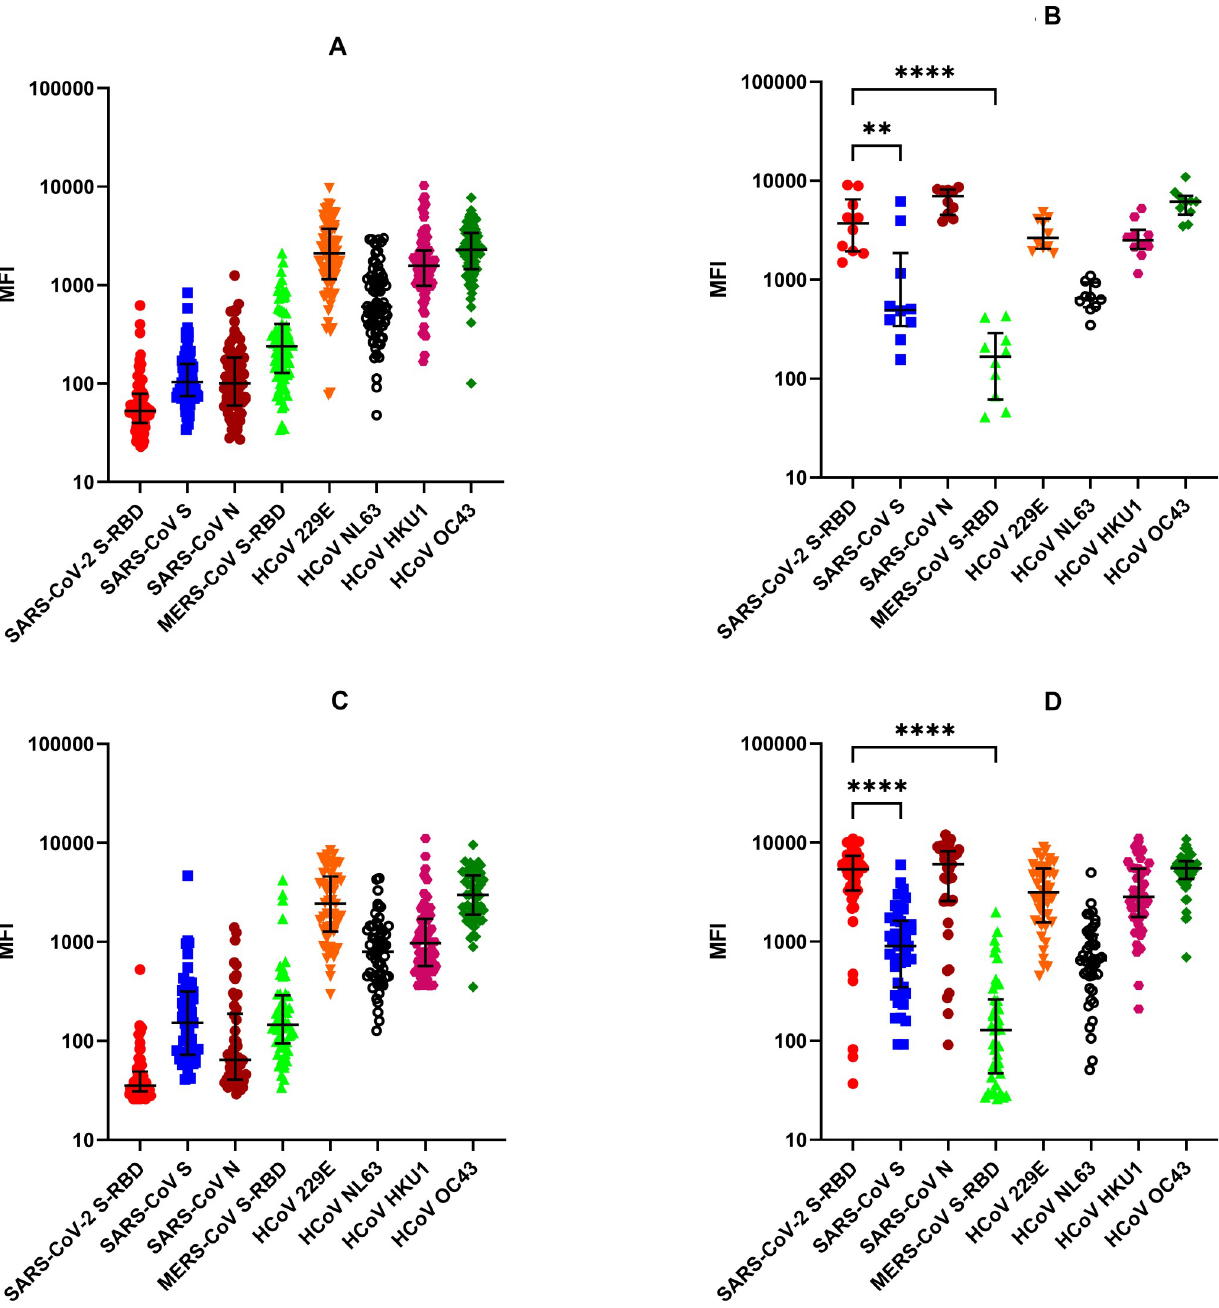
Fig 4. Total IgG levels detected by the multiplex antibody test against SARS-CoV-2 S-RBD, SARS-CoV S & N, MERS-CoV S-RBD and HCoVs. MFI values in log10 scale and IQR are shown, and the P values by one-way ANOVA and Tukey’s multiple comparison test between the groups are as follows: �� p < 0.001, ���� p < 0.0001. (A) Healthy Controls from USA, (B) COVID-19 Patients from USA, (C) Healthy Controls from Pakistan, and (D) COVID-19 Patients from Pakistan. In patients where multiple time points were available, the latest time point post-onset of symptoms is shown.